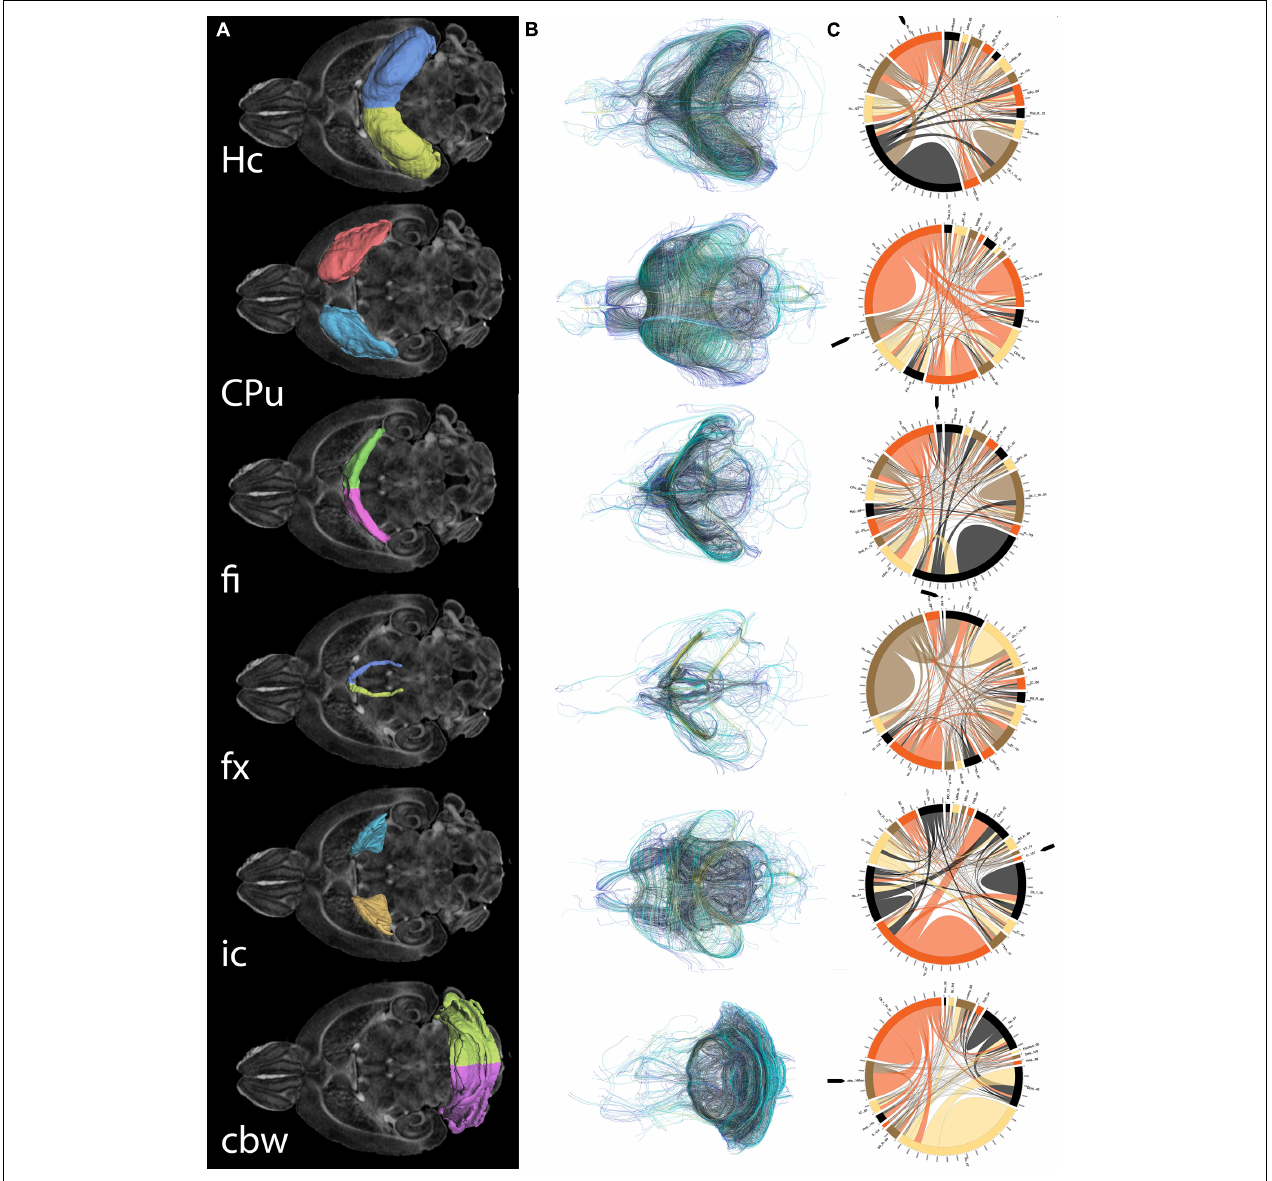
FIGURE 5 | Regions of interest for spatial navigation and their MRI associated metrics. We segmented selected brain regions involved in spatial navigation, including the hippocampus (Hc), caudate putament (CPu), and their major connections (fimbria: fi, and fornix: fx; and internal capsule : ic, respectively), to which we added the cerebellar white matter, and we have measured their volumes (A) . These regions were characterized by diffusion based measurements, which characterize microstructure through texture, and may vary along tracts (such as fractional anisotropy) (B) . Finally we characterized their connectivity with other brain regions (C) . Abbreviations and region indices correspond to the CHASS atlas (Calabrese et al., 2015; Anderson et al., 2019) and Paxinos mouse brain atlas: Hc, hippocampus; CPu, caudate putament; fi, fimbria; fx, fornix; ic, internal capsule; cbw, cerebellar white matter.